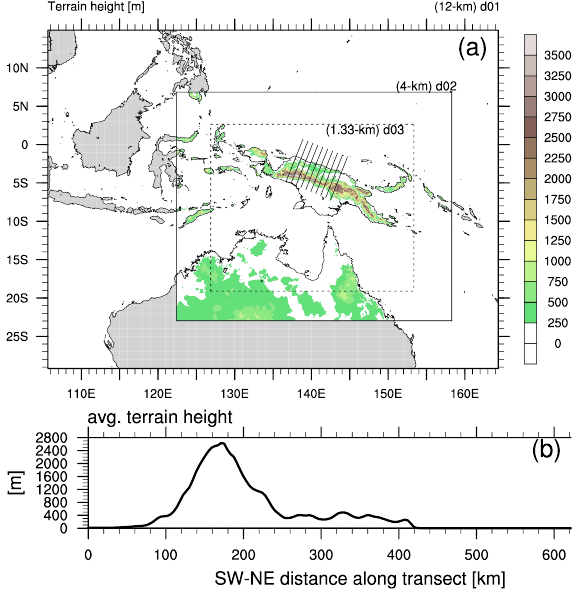
Figure 1. (a) Model domains and orography. The profile shown in panel (b) represents the mean terrain height (m), as averaged across the line sections shown in panel (a)